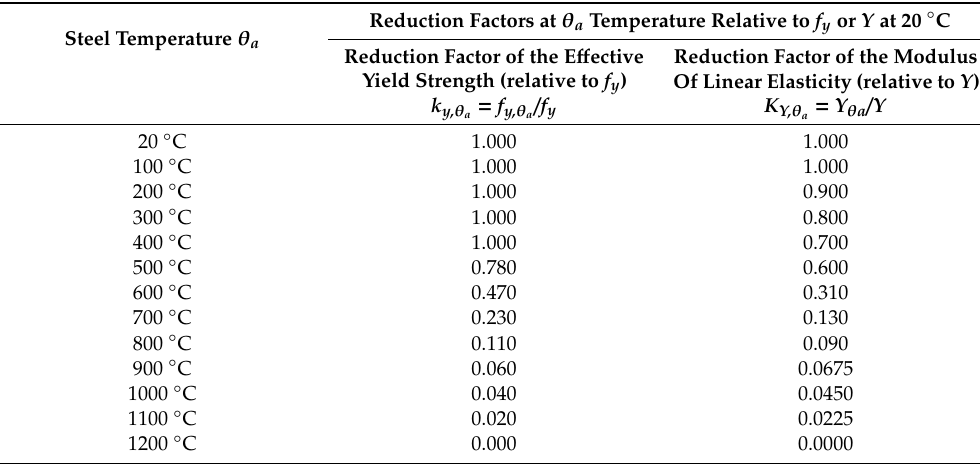
Table 1. Reduction factors for yield strength and modulus of elasticity